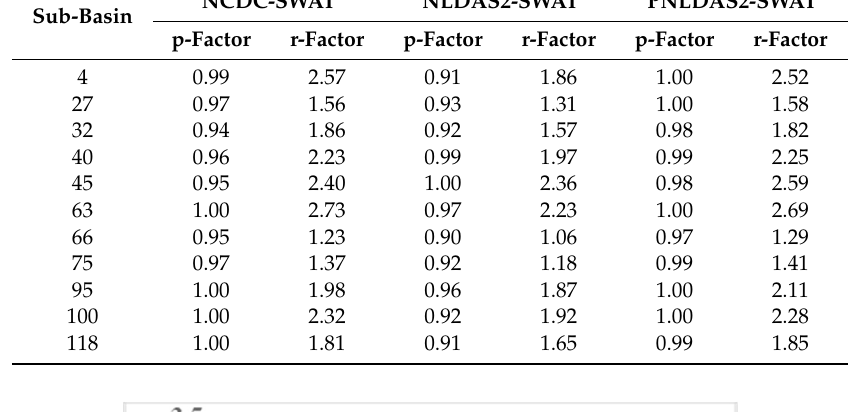
Table 5. p-factor and r-factor for di ff erent sub-basins in three simulation scenarios.